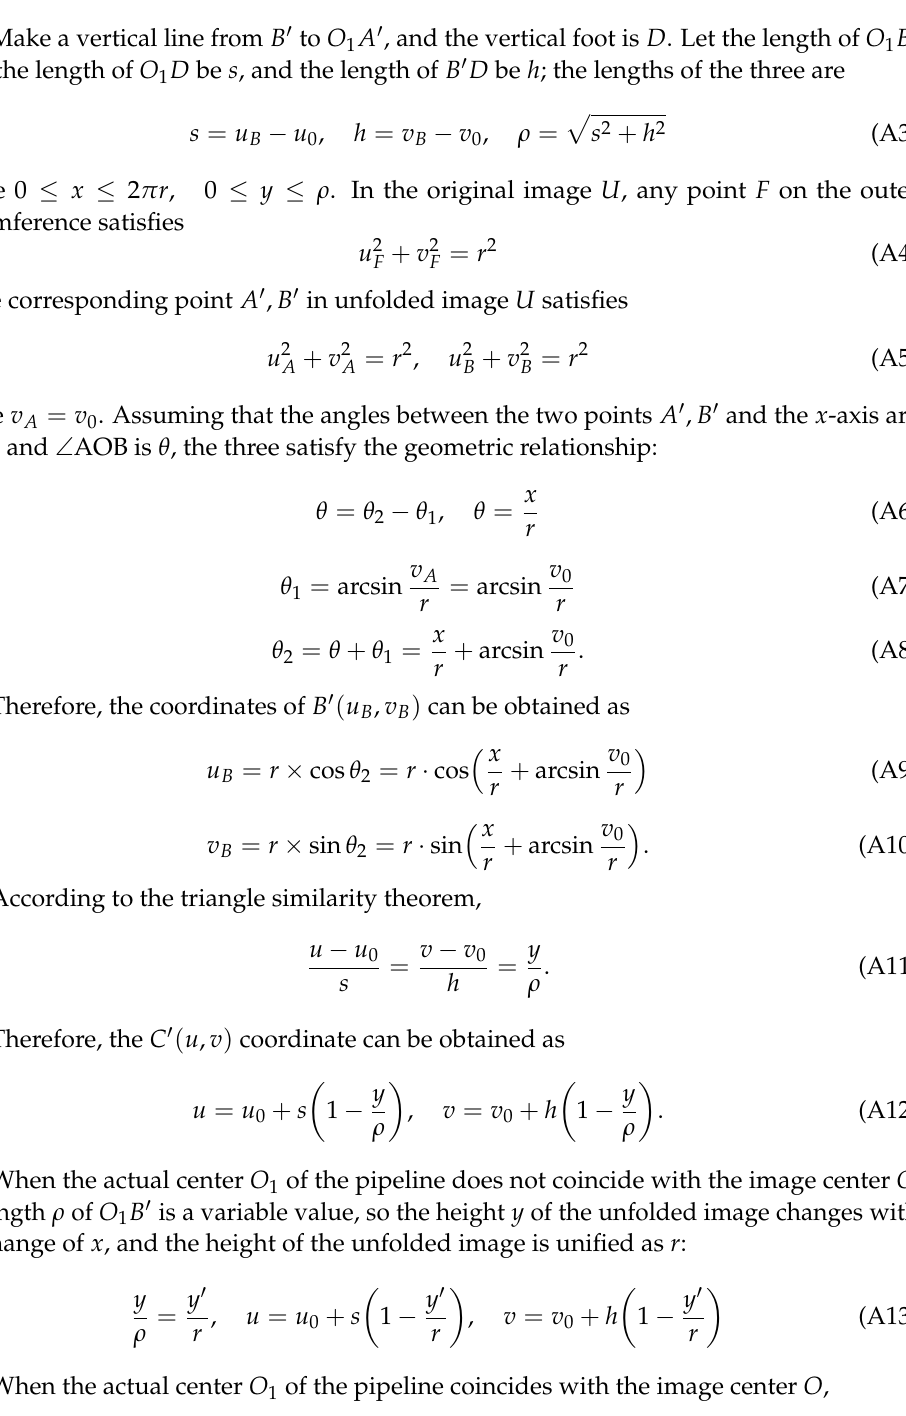
Figure A2. Unfolded image